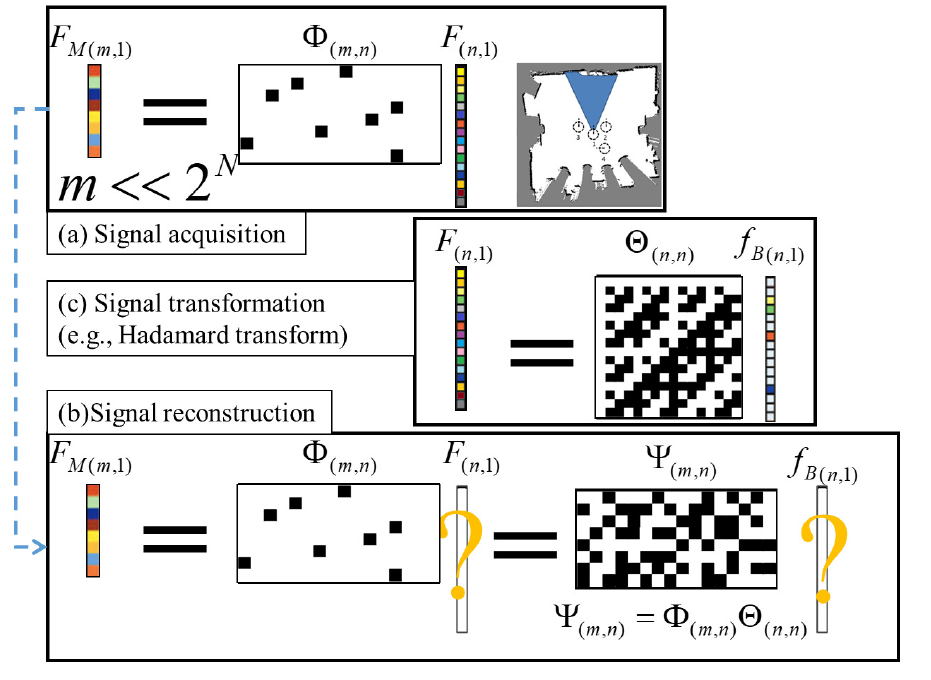
Figure 3. Illustration of the compressed sensing concept [3]. ( a ) F M ( m ,1 ) is collected by the system after taking measurements from a signal F ( n ,1 ) . The color cells represent real values and black/white cells represent binary values (0 and 1 in Φ while 1 and -1 in Θ .) ( b ) The system has F M ( m ,1 ) and tries to recover F ( n ,1 ) . ( c ) The signal F is sparse in the Fourier domain. In this example, m is 8, n is 16 and k is 4. Given Φ m , n and F M ( m ,1 ) , it’s impossible to recover F ( n ,1 ) ( m < n ). But, given recovered ( k < m